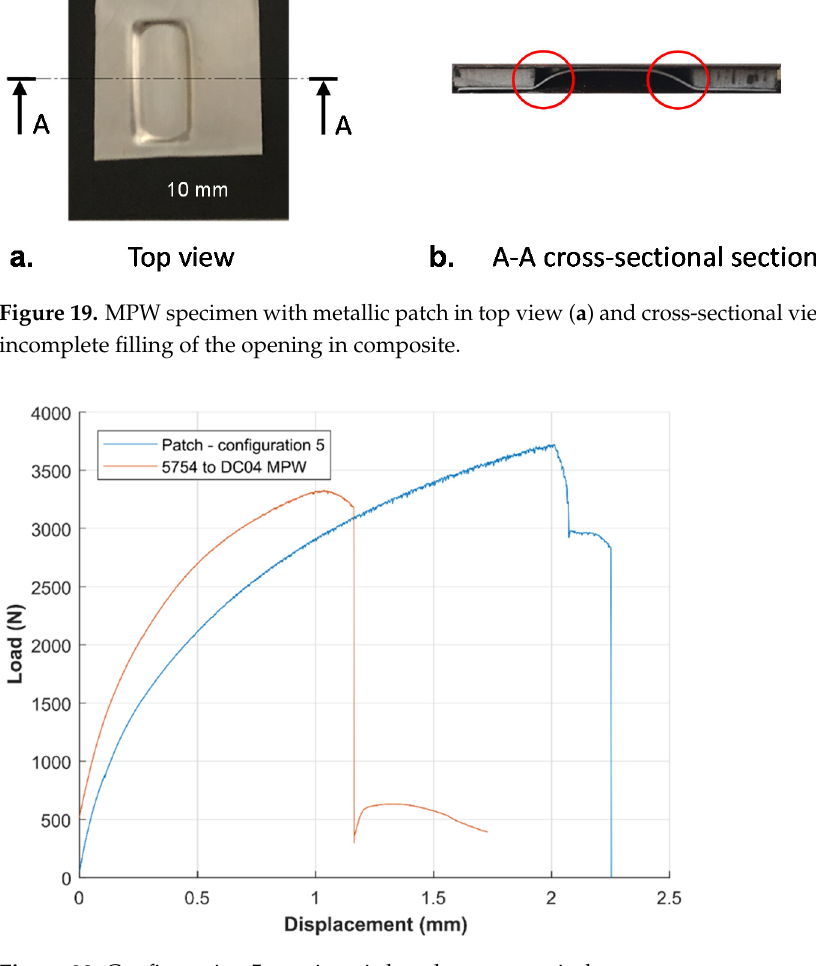
Figure 20. Configuration 5 quasi-static lap-shear test typical curve.